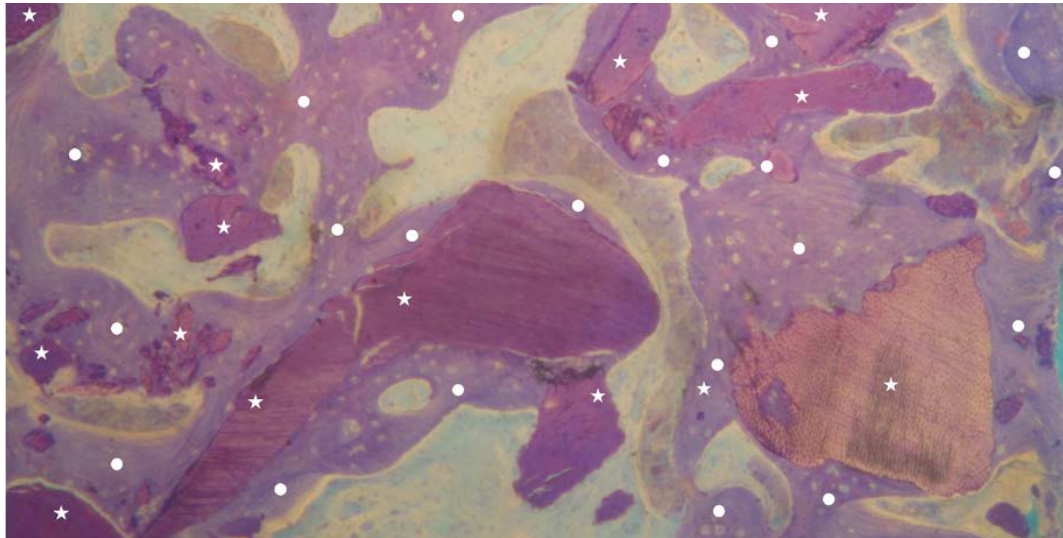
Figure 4. Group 2: newly formed bone trabeculae (indicated by white circles) and dentin matrix graft particles (indicated by white stars) are visible. It is possible to observe granules almost completely surrounded by new bone (indicated by white circles). No inflammatory or other adverse reaction is visible around the particles (magnification 25×; toluidine blue).